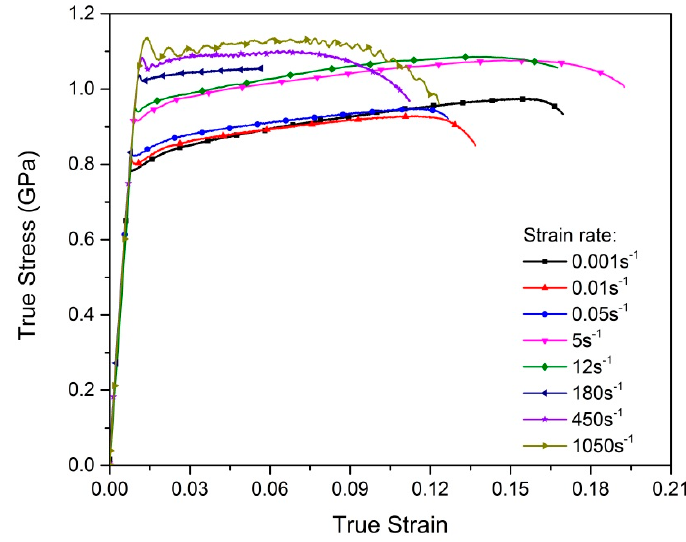
Figure 2. Experimental stress–strain responses in uniaxial tension for Ti–5Al–2.5Sn alloy.